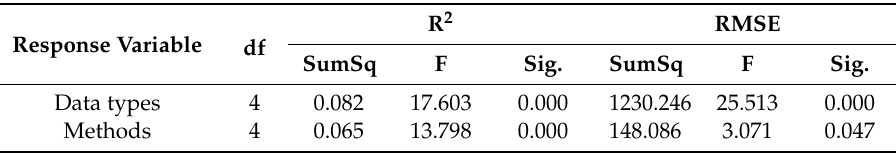
Table 4. Results of ANOVA conducted to explain the variance of R 2 and RMSE obtained for the different experiments. SumSq, Sum of